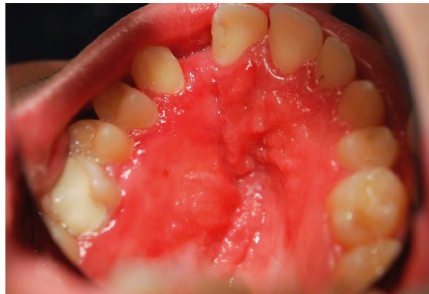
Figure 1: Erythematous, denture-related candidiasis in a 14-year-old boy (photography taken in an intraoral mirror).